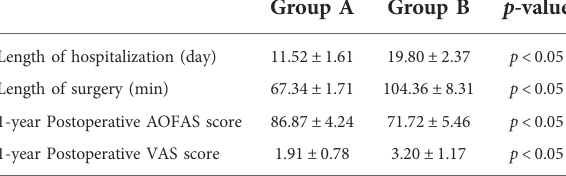
TABLE 2 Comparisons of treatment results between patient